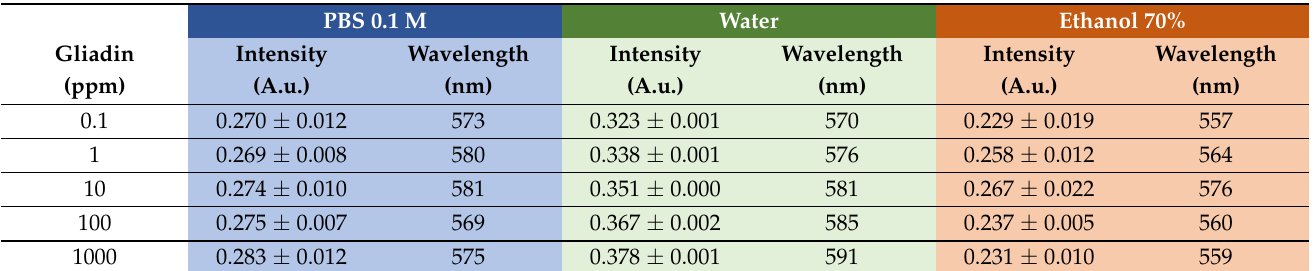
Table 1. Summary of plasmonic evolutions (maximum peak intensity and their wavelength position) of biofunctionalized AuNPs with anti-IgG gliadin antibodies suspended in three individual solutions: in 0.1 M PBS (blue color); in 70% ethanol (in orange) and in ddwater (in green). (A.u.—absorbance units).